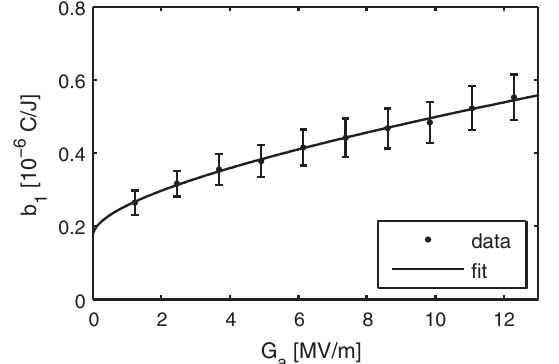
FIG. 5. Second-order coefficient b 2 as a function of acceler- ation field G a